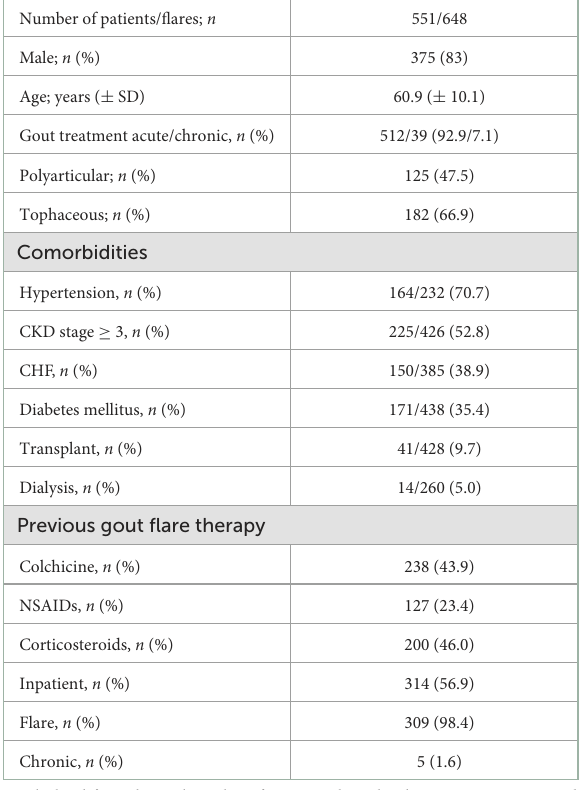
TABLE 2 Comorbidities, demographic and clinical characteristics of gouty arthritis patients reviewed. Number of patients/flares;